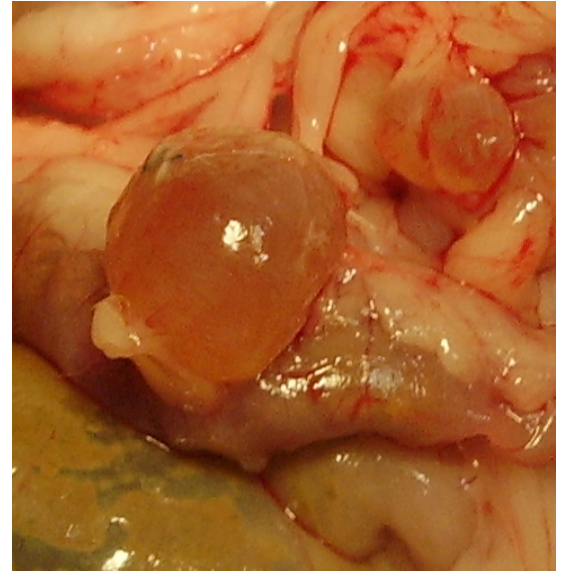
FIGURE 2 - Photomicrography showing an autotransplant with a diameter longer than 4.5 mm, classified as grade III according to Quereda et al . 9